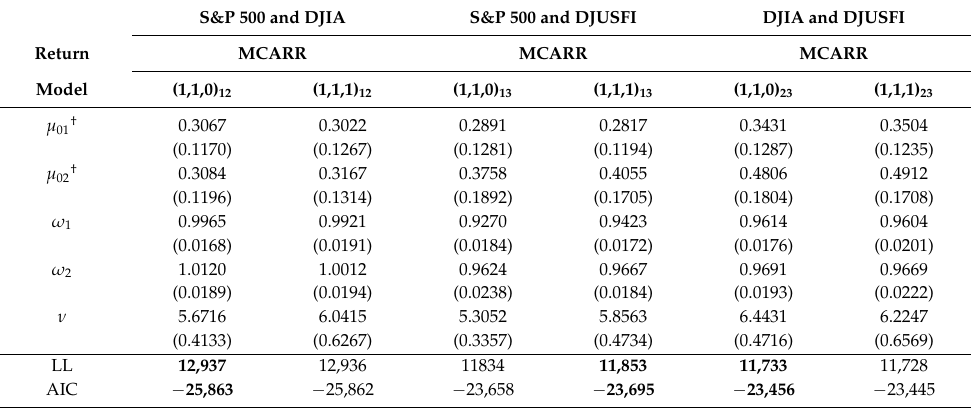
Table 5. Parameter estimates, standard errors (in parentheses), model performance measures LL and AIC for in-sample estimation of the return model for the two-stage MCARR-return model using volatility estimated from MCARR(1,1,0) and MCARR(1,1,1) volatility models. Models with boldface LL and AIC are the best models used in forecasting.